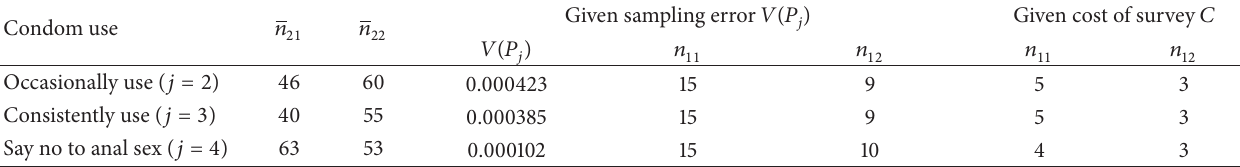
Table 2: Sample size for occasional, consistent condom use, and never having anal sex among MSM in